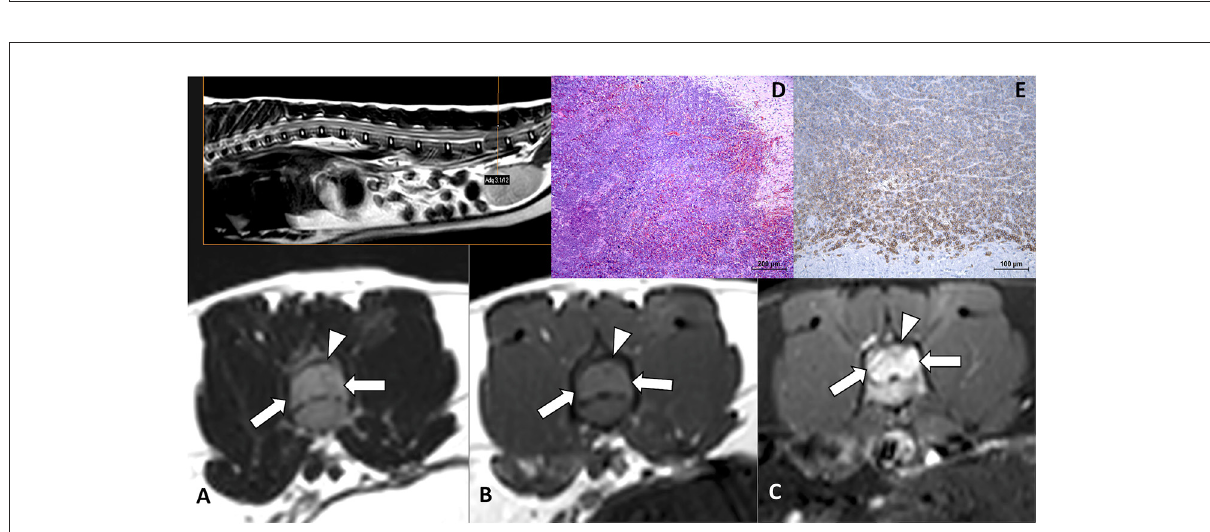
FIGURE5 Intermediate-large B-cell lymphoma in an 8-month-old domestic shorthair cat with a history of progressive paraparesis and caudal lumbar spinal pain for 10 days. On MRI transverse planes at the level of L6 (A–C) , there is an epidural lesion isointense on T2W (arrows in A ) and T1W (arrows in B ) images. On T1W post-contrast SPIR (C) there is an intense enhancement of the lesion (arrows) as well as diffuse vertebral bone marrow enhancement. The spinal cord appears severely compressed with dorsal displacement (arrowheads in A–C ). On HE stain of tissue biopsy (D) , there are neoplastic lymphoid cells, mixed with erythrocytes, infiltrating nervous tissue. B lymphocytes, CD20-immune positive cells, predominate in the tumor in IHC (E) .